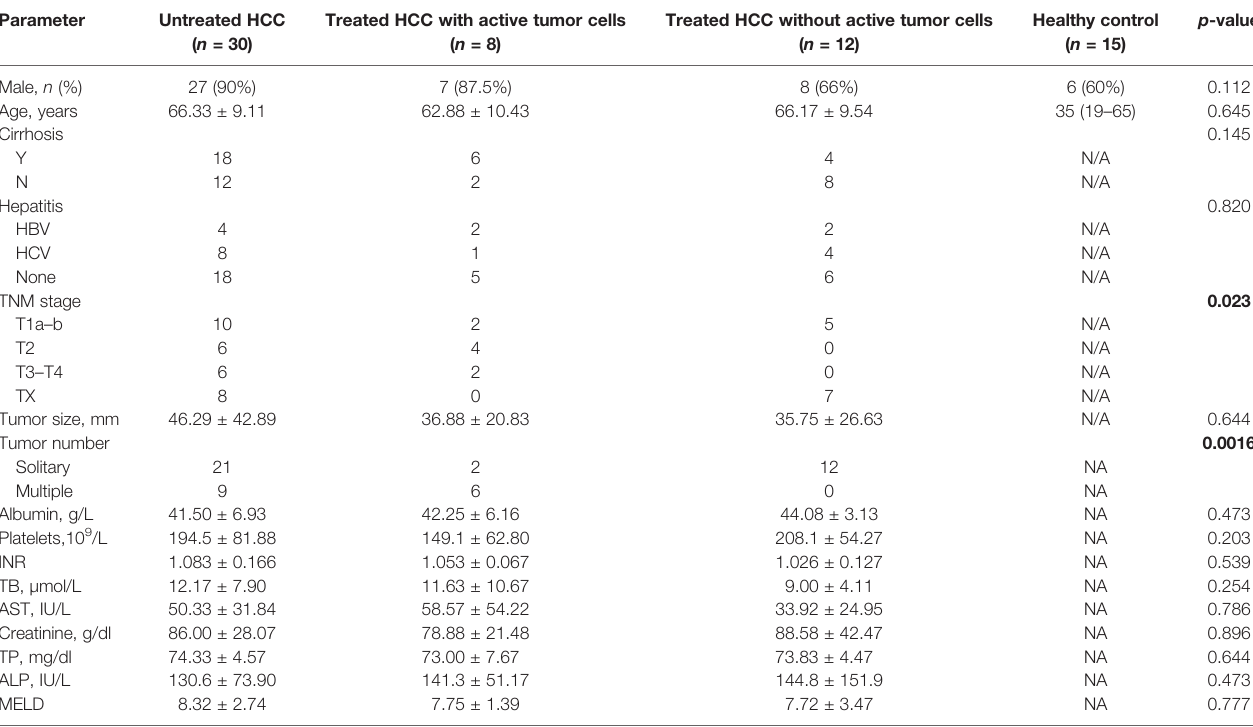
TABLE 1 | Baseline characteristics of HCC